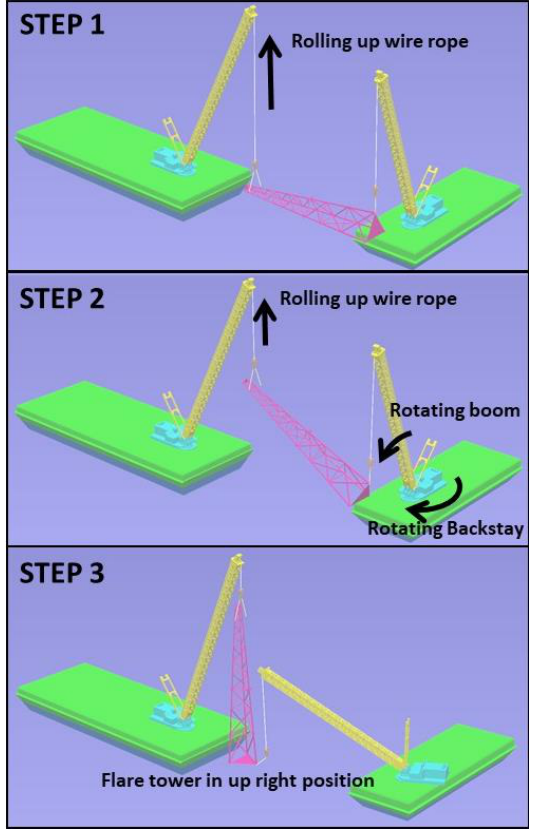
Figure 17. Procedure of model test.